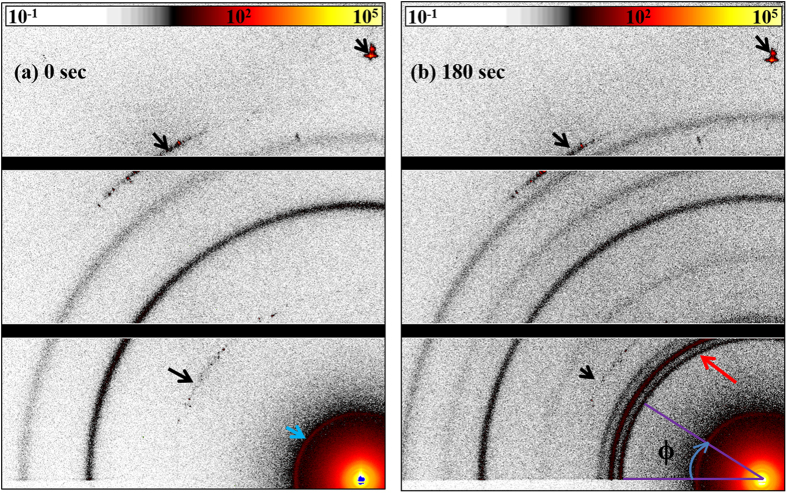
GIXD detector images.GIXD detector images collected for (a) the native AgTF and (b) for the same film after an exposure to iodine for 180 s. Some scattering artefacts originating from the Si substrate at sample edges (black arrows) or from the detector itself (blue arrow) are indicated. The red arrow points to the intersection line of the Debye-Scherrer cone of the (100) Bragg reflection of β-AgI with the detector plane.